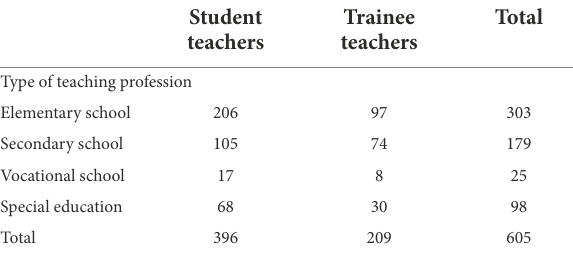
TABLE 1 Sample distribution by student or trainee teacher status and type of teaching